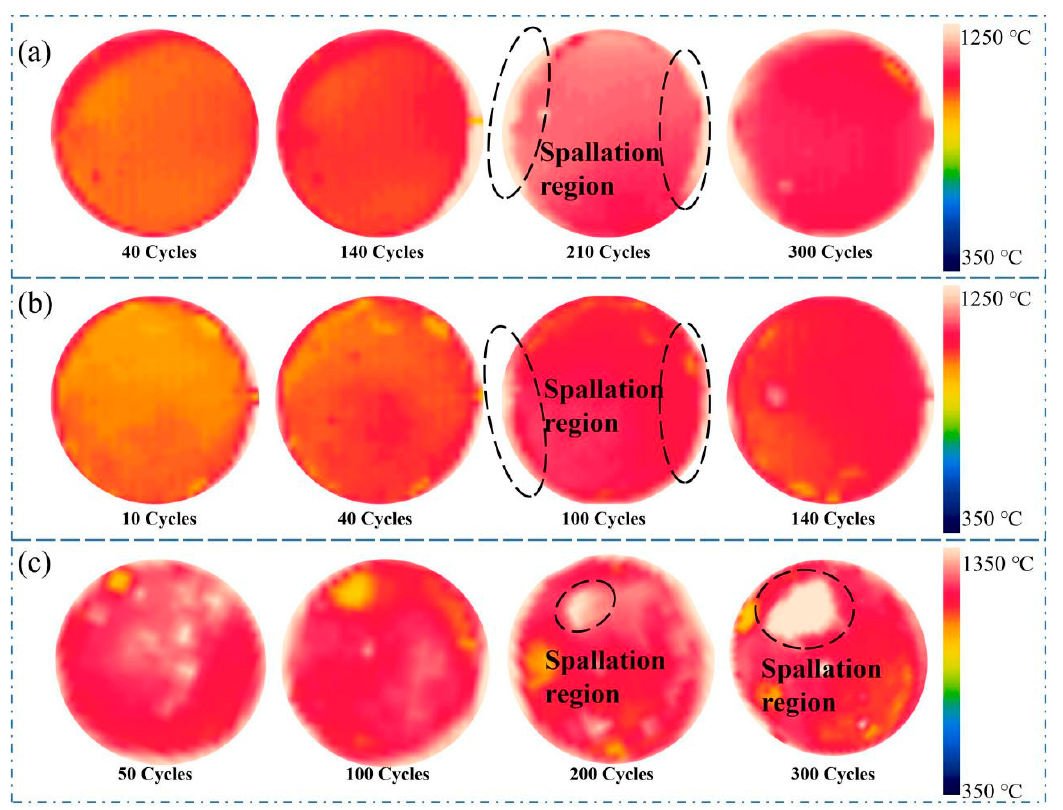
Figure 6. Evolution of infrared thermal images with thermal shock cycles during the holding stage: ( a ) specimen 1; ( b ) specimen 2; and ( c ) specimen 3.